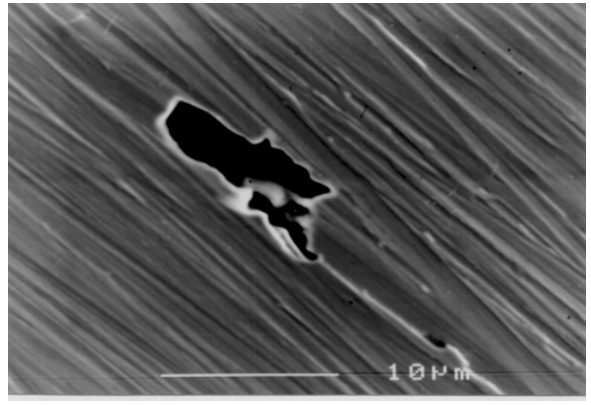
Figure 4. Corrosion pit formed on solution annealed AV2205 alloy after the cyclic potentiodynamic polarization test. SEM - secondary electrons image. 3000X.